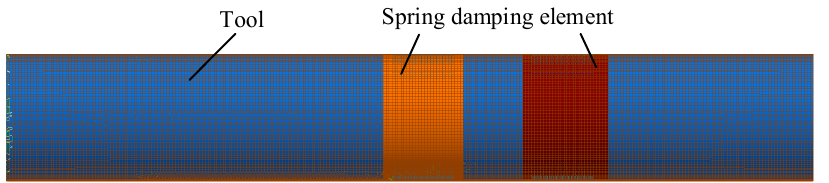
Figure 7. The finite element model.